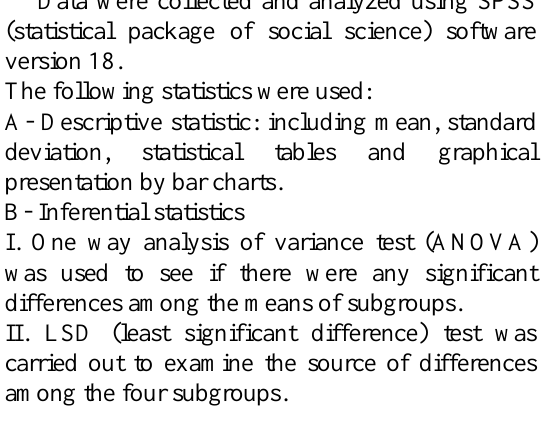
Figure 6: Image of one millimeter at 280X magnification.